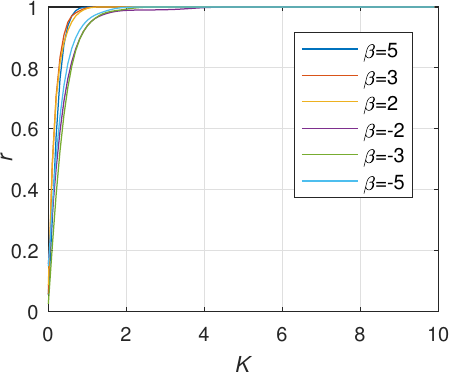
Figure 19. The stability of the weighted directed network when β is ± 2, ± 3, ± 5).